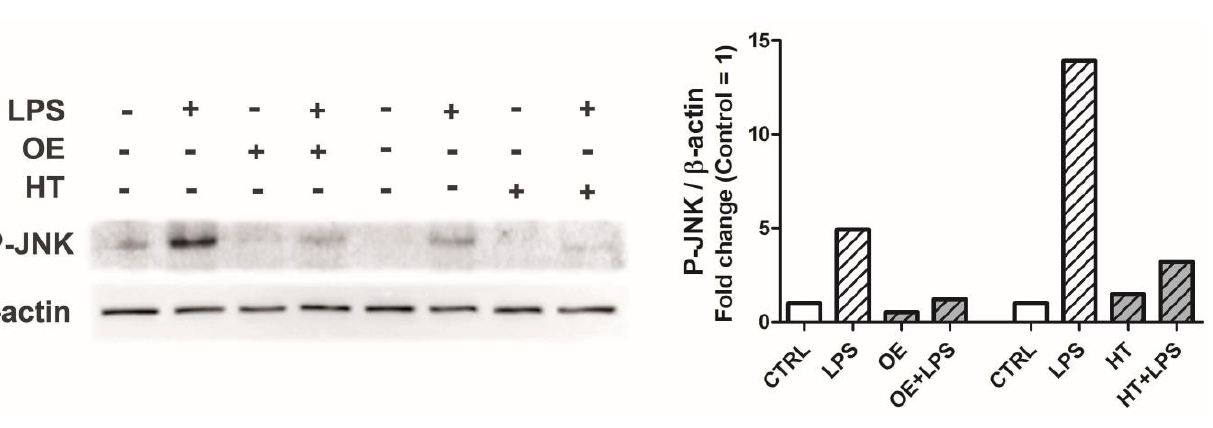
Figure 5. Left : activation of JNK by LPS exposure in primary OA chondrocytes. To account for the different solubility requirements of the two polyphenols, two different set of samples were prepared, with either DMSO as a vehicle (to assess OE effects) or ethanol (to assess HT effects). Right graph : quantification of phosphorylated JNK intensity relative to β -actin, and expressed as fold change relative to the control for each set of samples. Stimulation with LPS increased the levels of phosphorylated JNK while pretreatment with either OE or HT prevented this activation.